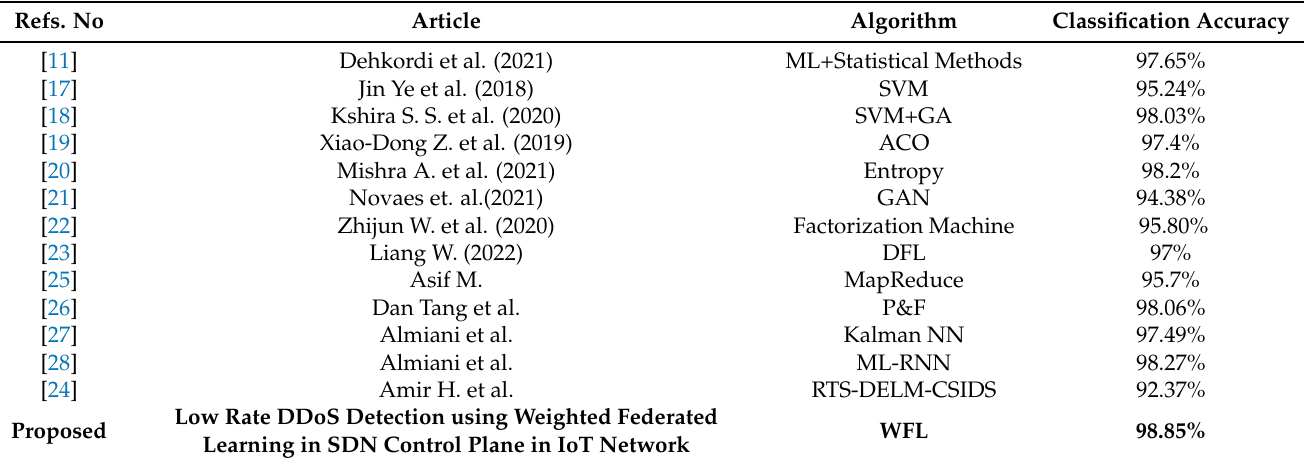
Table 7. Comparison with the existing